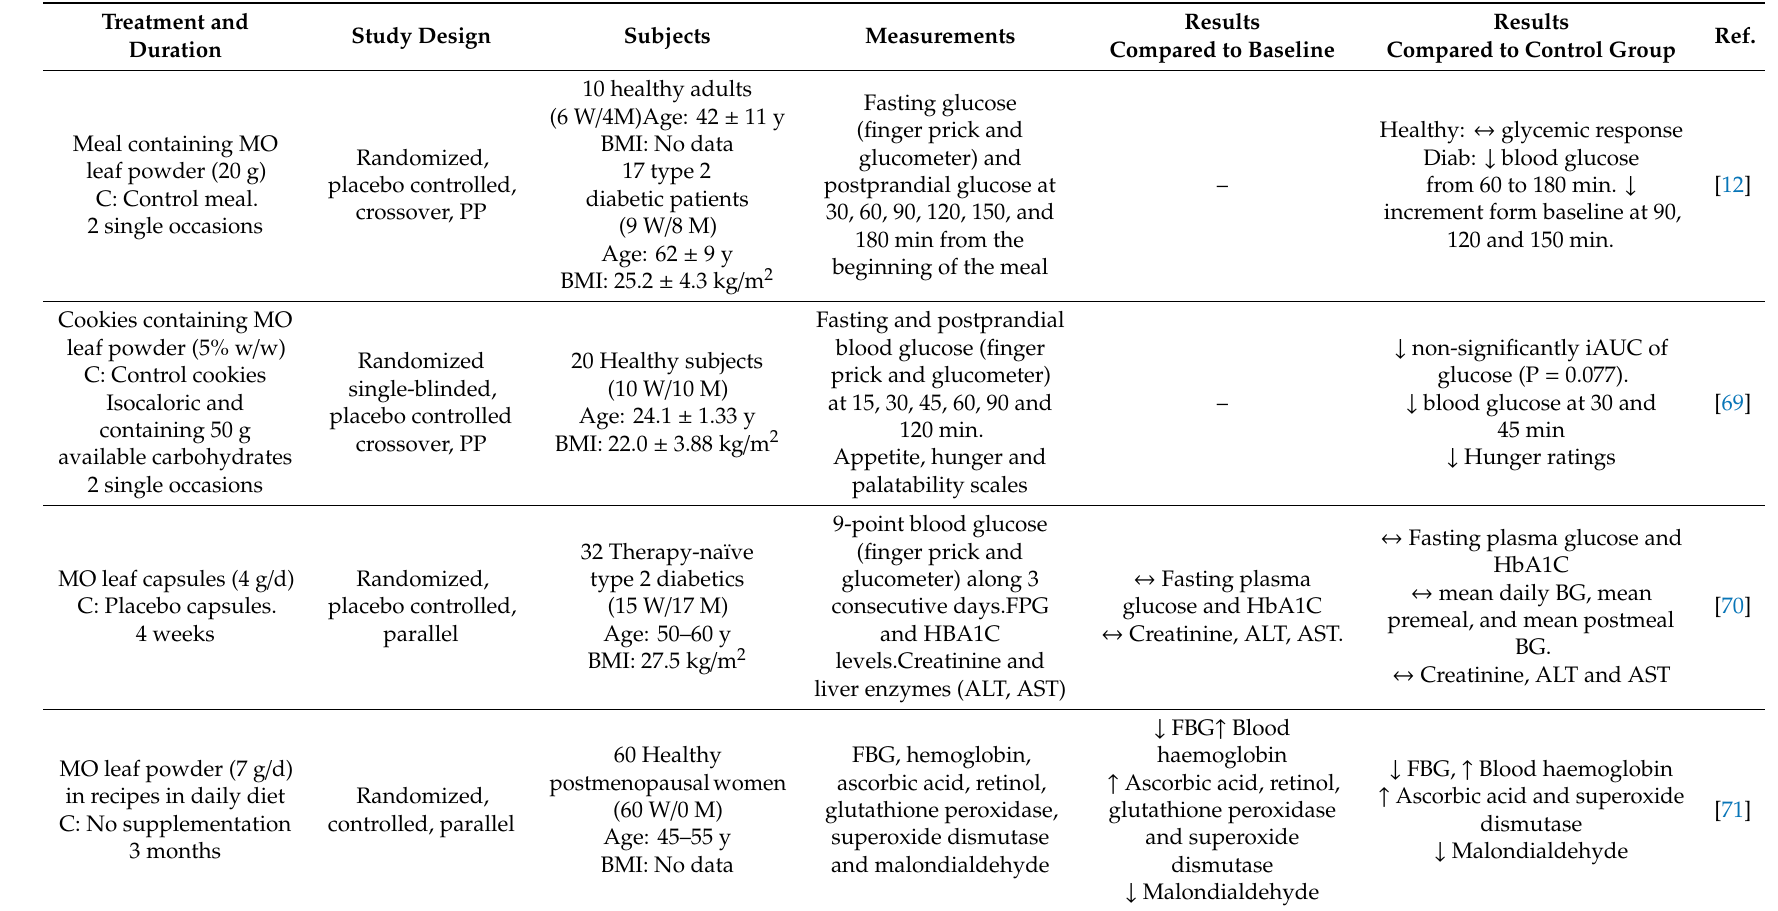
Table 2. Evidence from human studies on the e ff ects of M. oleifera on glycemic control and related parameters in healthy and type 2 diabetic